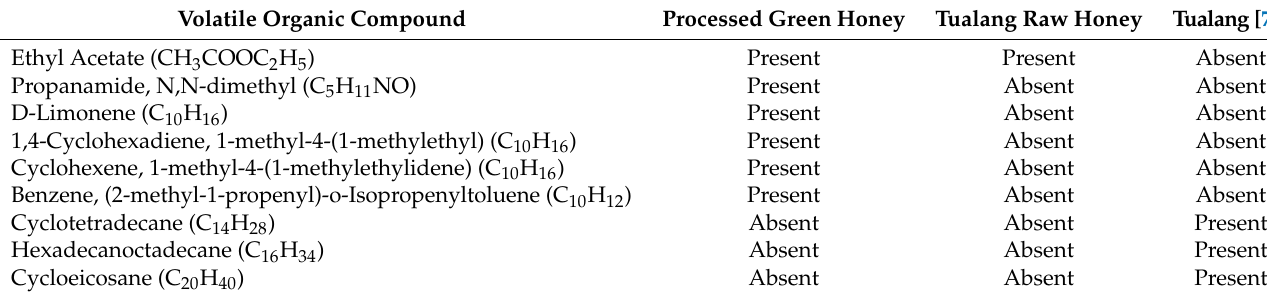
Table 5. Volatile composition in green honey compared with